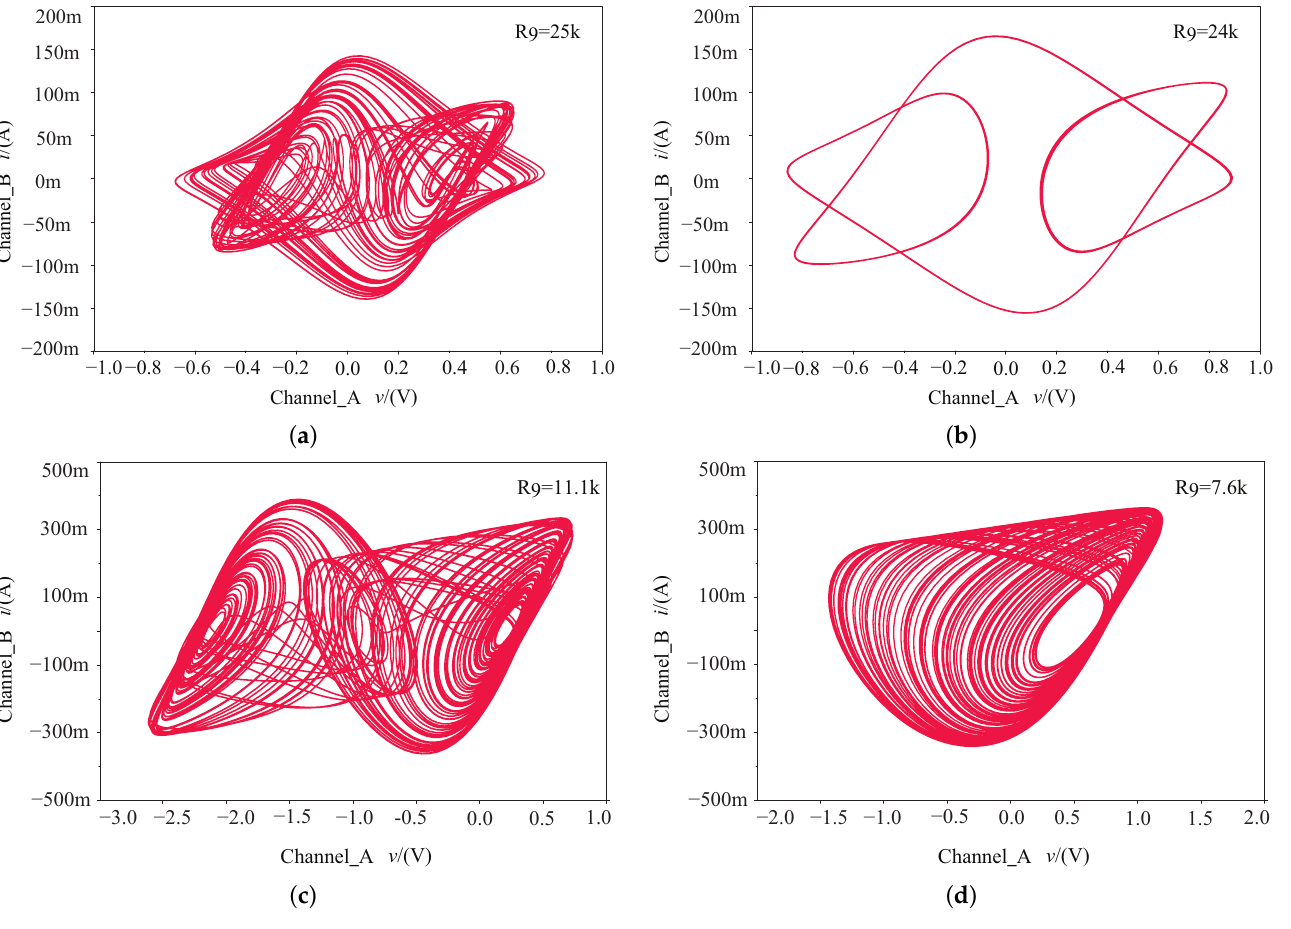
x 2 plane. ( a ) Single-scroll periodic- −